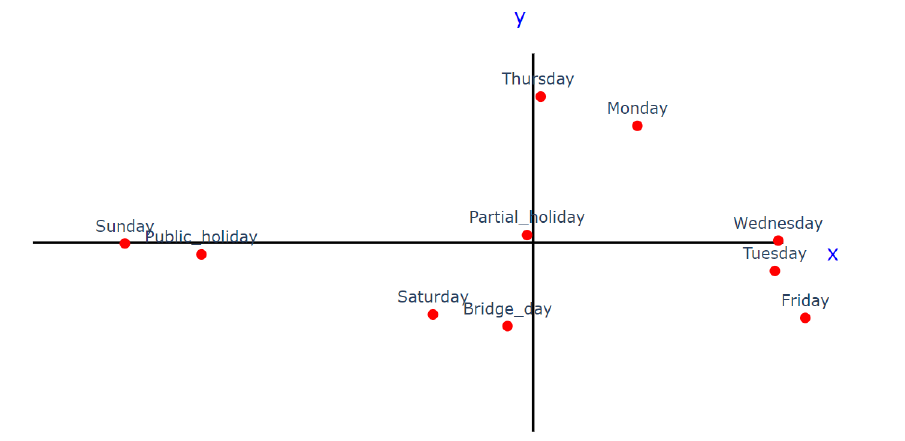
Figure 15. Weekdays in the embedding